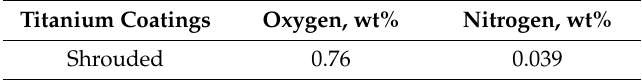
Table 4. The oxygen and nitrogen contents in the as-sprayed titanium coatings.